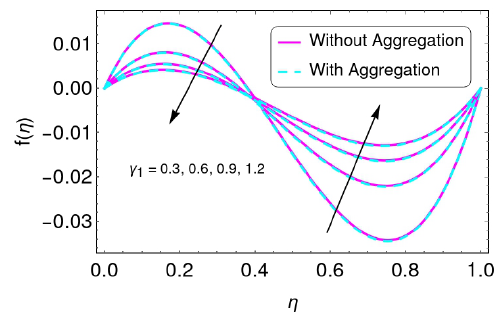
Figure 8. Characteristics of γ 1 for distribution f ( η )